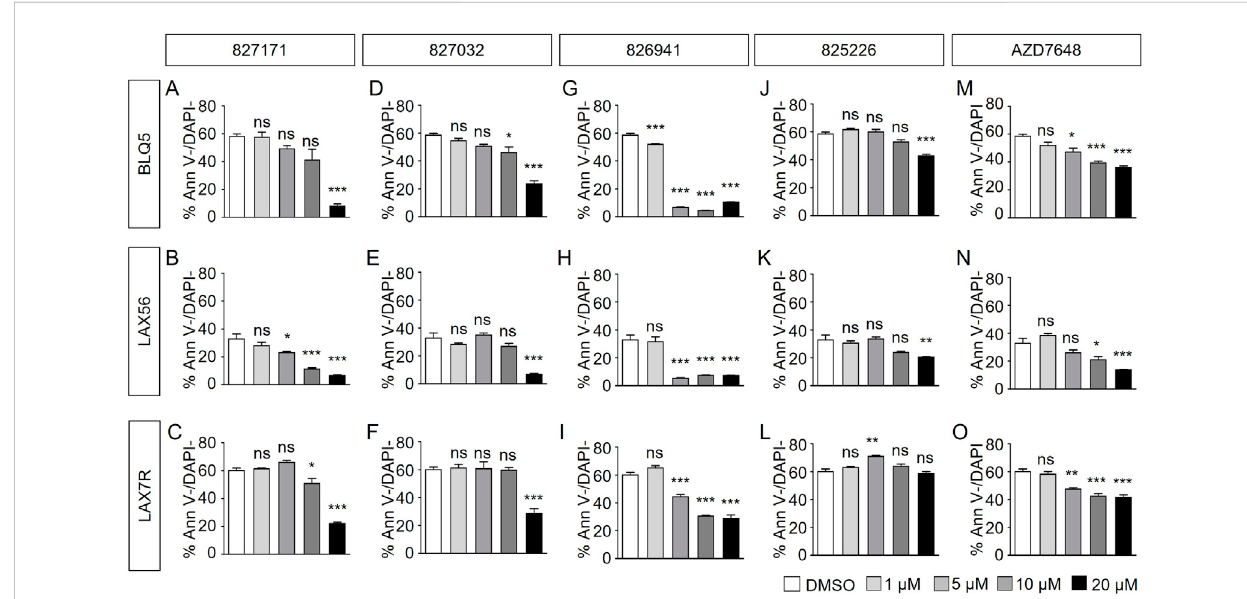
FIGURE 3 Artemis inhibitorsand DNA-PK inhibitor AZD7648 effects onviability of B-ALL cells. B-ALL cells (BLQ5, LAX56 and LAX7R) were treated with Artemis inhibitor 827171 (A – C) , 827032 (D-F), 826941 (G – I) , 825226 (J – L) and DNA-PK inhibitor AZD7648 (M – O) with indicated concentrations. On day three, primary B-ALL cells were collected and used for fl ow cytometry analysis with PE Annexin V and DAPI to measure % viability (PE Annexin V-/DAPI-). The statistical analysisofviability differences iscompared to DMSO control: ns: non-signi fi cant;* p < 0.05;** p < 0.001; *** p < 0.0001,one-way ANOVA.